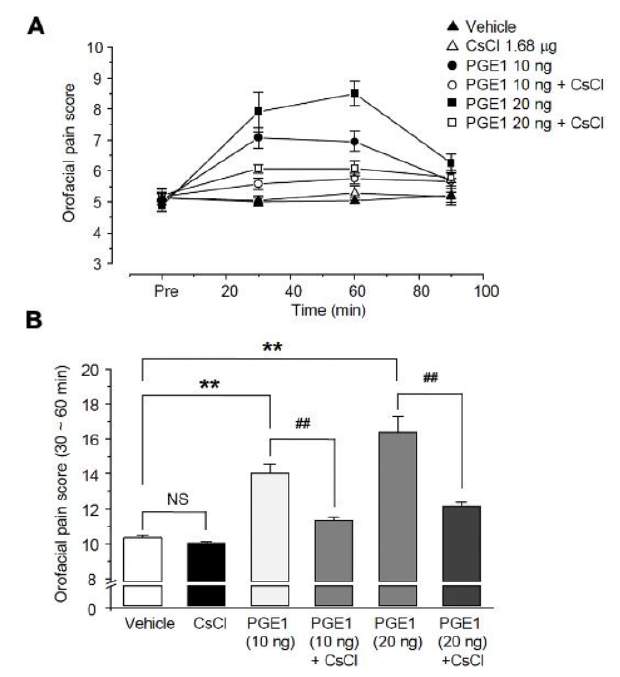
Figure 4. Role of HCN channels in PGER1-induced pain. ( A ) The orofacial pain score from a representative pain behavior for 90 min after the application of the vehicle, PGE1 (10 and 20 ng/10 µ L), and a combination of PGE1 and CsCl (1.68 µ g/10 µ L) into the whisker pad of mice. PGE1 induced the mechanical allodynia in a dose-dependent manner (10 and 20 ng), and normal behavior was observed after 90 min. The observed PGE1-induced mechanical allodynia was blocked by CsCl, HCN blocker. ( B ) Summary of the orofacial pain scores measured for 30–60 min in each group. Results are presented as the mean ± SEM (** p < 0.001 compared to the vehicle group, ## p < 0.001 compared to the PGE1 group, one-way ANOVA, NS: not